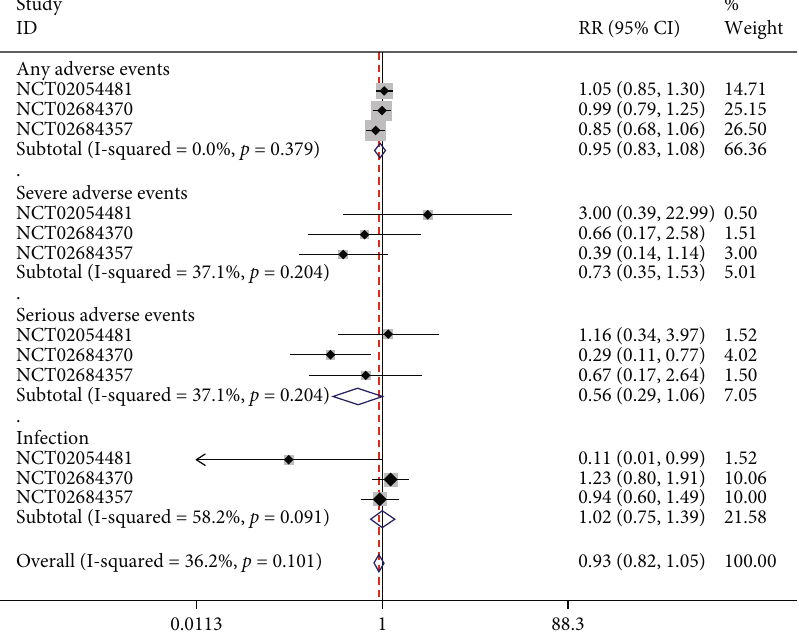
Supplementary fi le 1: search strategies in PubMed.